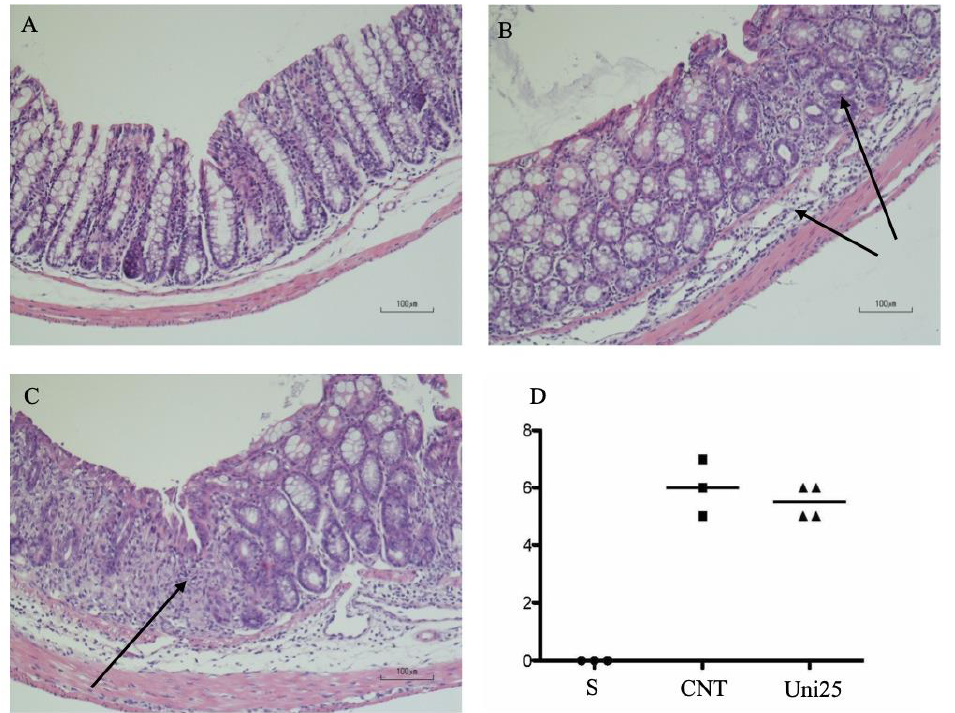
Figure 3. Representative hematoxylin-eosin stained sections of colonic specimens harvested from vehicle-treated S mice ( A ) and from TNBS-treated mice administered with vehicle ( B ) or UniPR1331 25 mg/kg ( C ). TNBS colonic instillation caused neutrophils infiltration and submucosal oedema (indicated by arrows) in vehicle-treated animals not attenuated in UniPR1331-treated mice ( C ). Panel ( D ) represents histological damage scoring of colonic sections obtained from vehicle-treated S mice ( ), CNT mice ( ) or UniPR1331-treated colitic mice ( ) (horizontal bar at the median value).